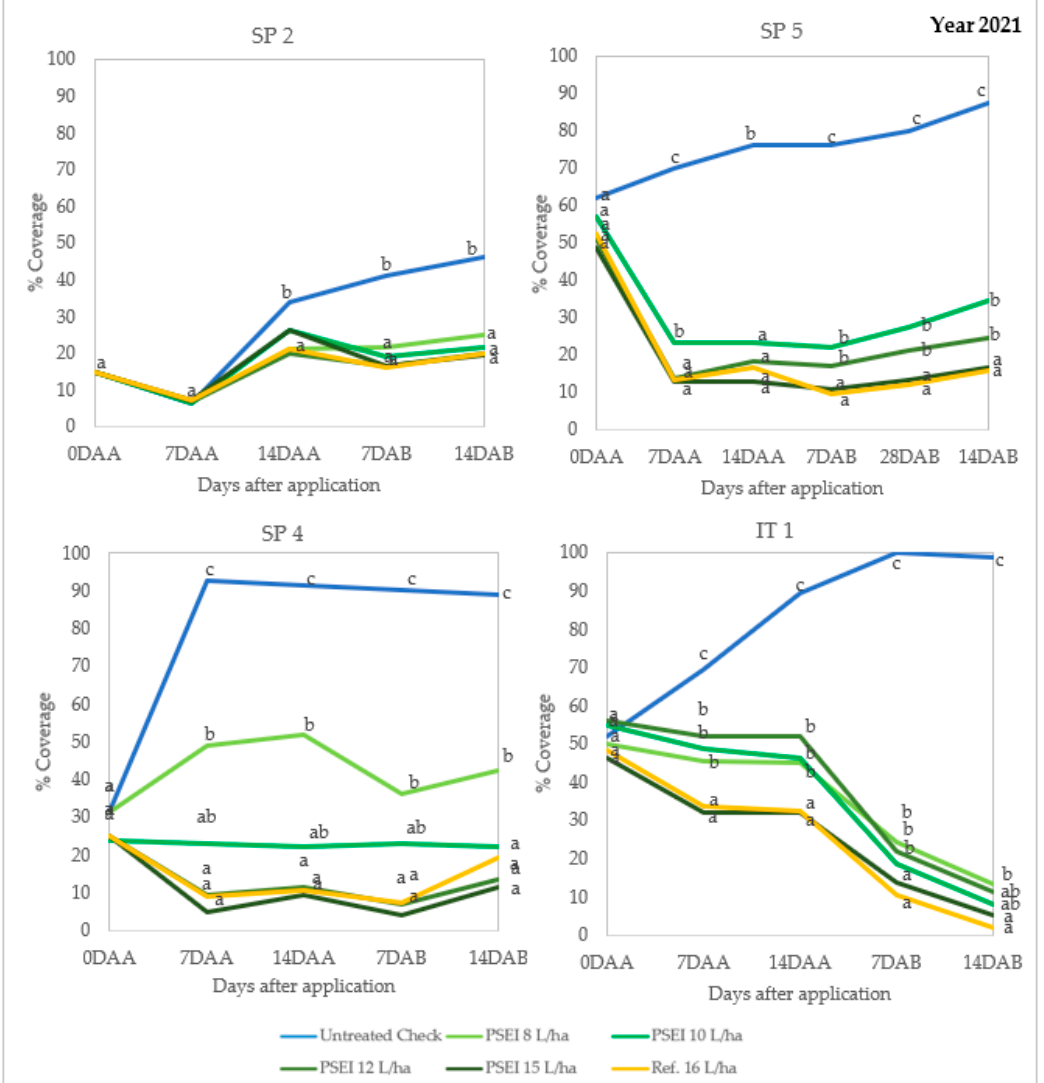
Values of all PA treatments were compared per year, fourteen days after the second application. Values are mean of % of weed coverage ± standard error. Different letters in the same column indi- cate significant differences ( p < 0.05).